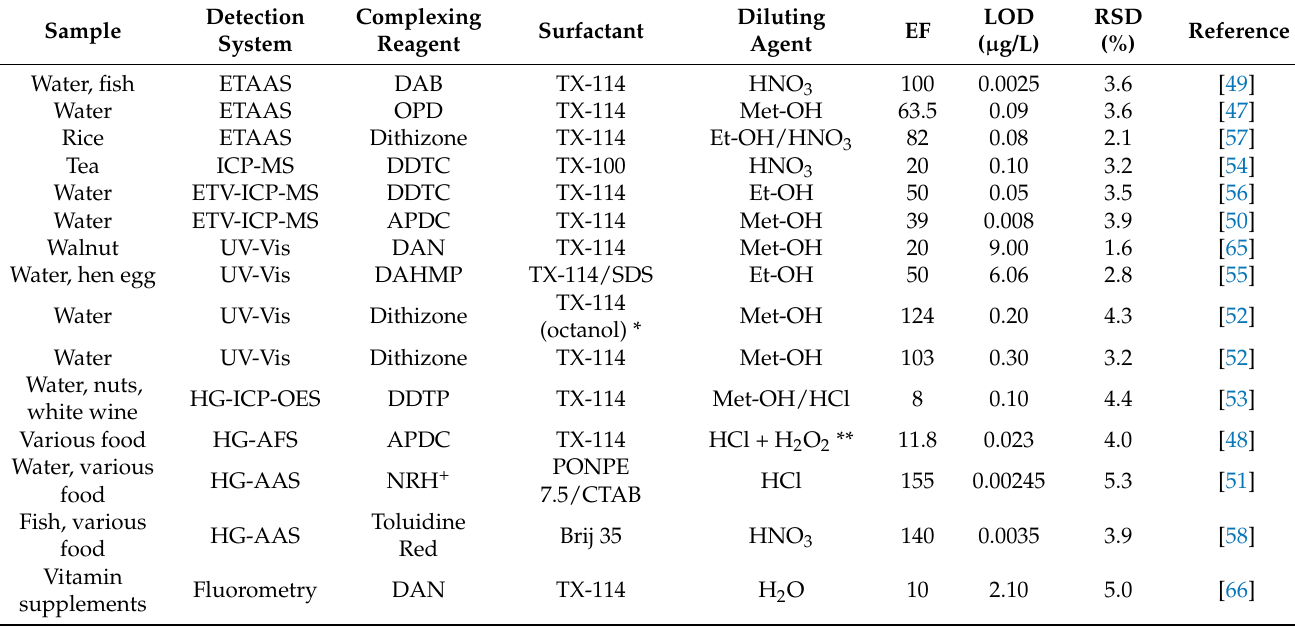
Table 1. Comparison of some analytical characteristics of the CPE methods proposed for Se(IV) separation and preconcentration and of methods for spectrometric quantification of this